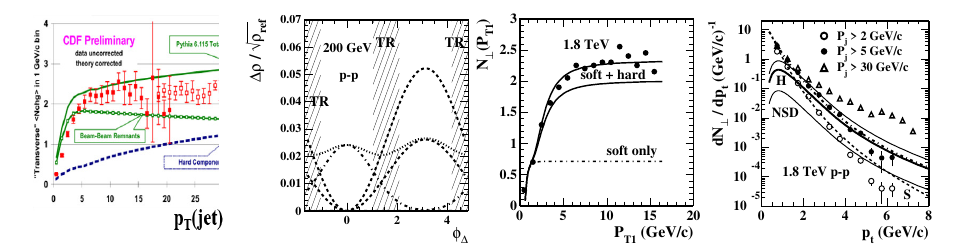
Figure 2. First: CDF data associated with the underlying event (points) compared to PYTHIA pre- dictions (curves). Second: Model functions derived from 2D angular correlations. Third: Data from first panel (points) compared to running integrals of single-particle spectra (solid curves). Fourth: N